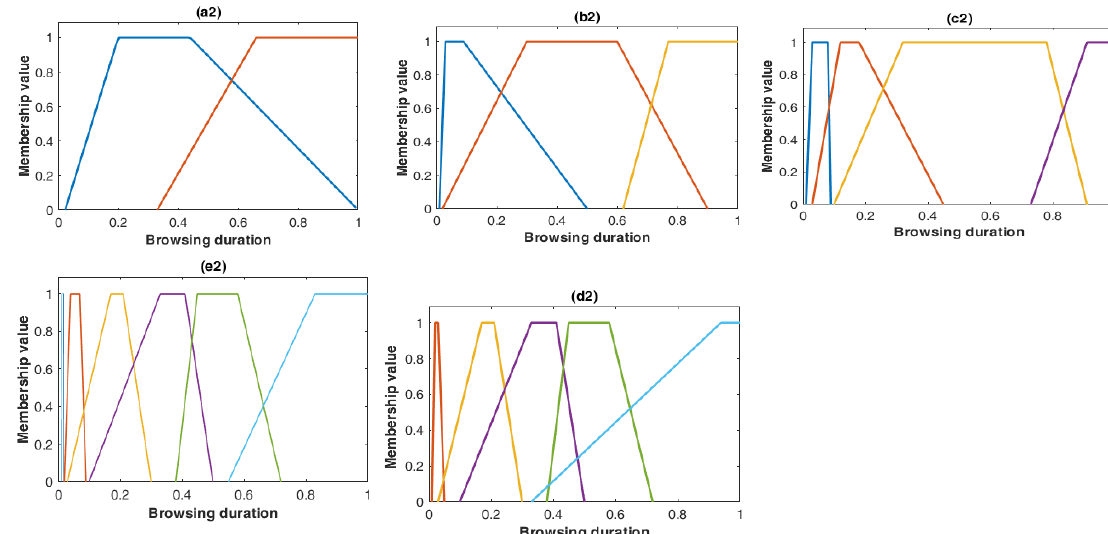
Figure 12 . Optimized membership functions after executing LA-OMF in the CTI dataset.